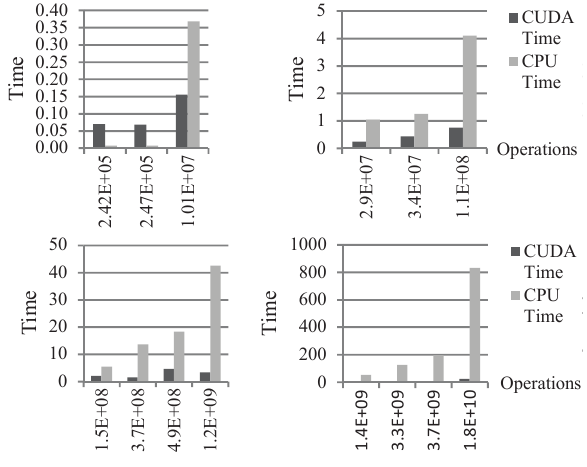
Figure 7: Computational time vs. number of point-to- point